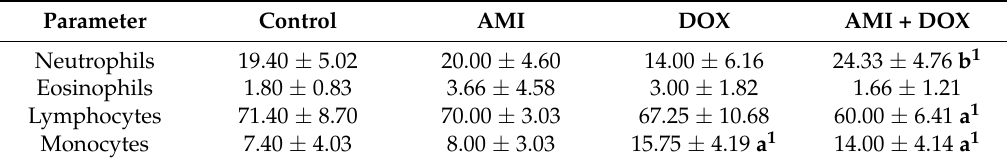
Table 3. The influence of different treatment on differential blood count (%) in the peripheral blood 28 days after receiving last